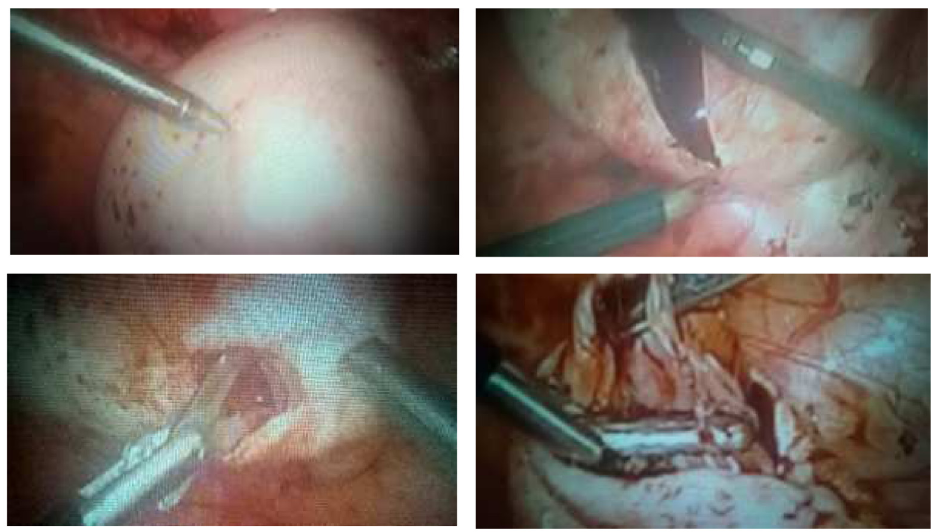
Figure 8. Endometrioma cystectomy. A correct dissection plane is mandatory for a careful cystectomy of endometriomas and must be clearly identified. Whenever possible, incision should be made at a site opposite the ovarian vascular pedicles. Image is from surgery performed by the